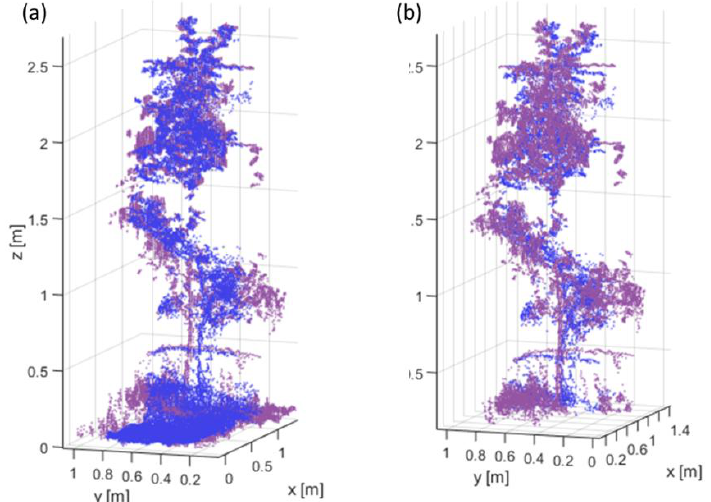
Figure 4. Registration and alignment using the iterative closest point algorithm (ICP) algorithm of a single tree point cloud in two cases ( a ) tree point cloud with soil points ( b ) tree point cloud after soil removal with RANSAC. The trees with the best results for each case are presented.